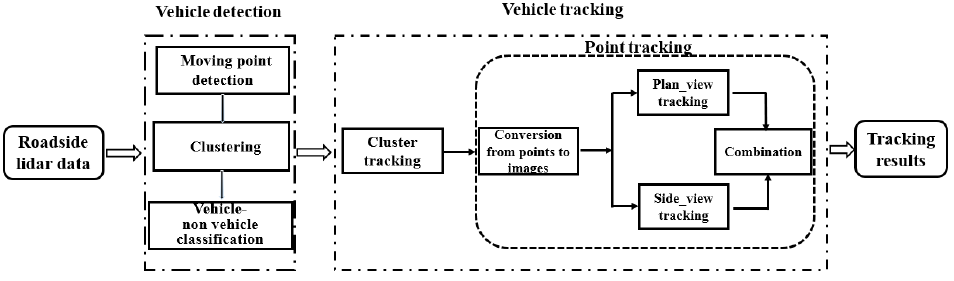
Figure 1. Framework of the proposed methodology.